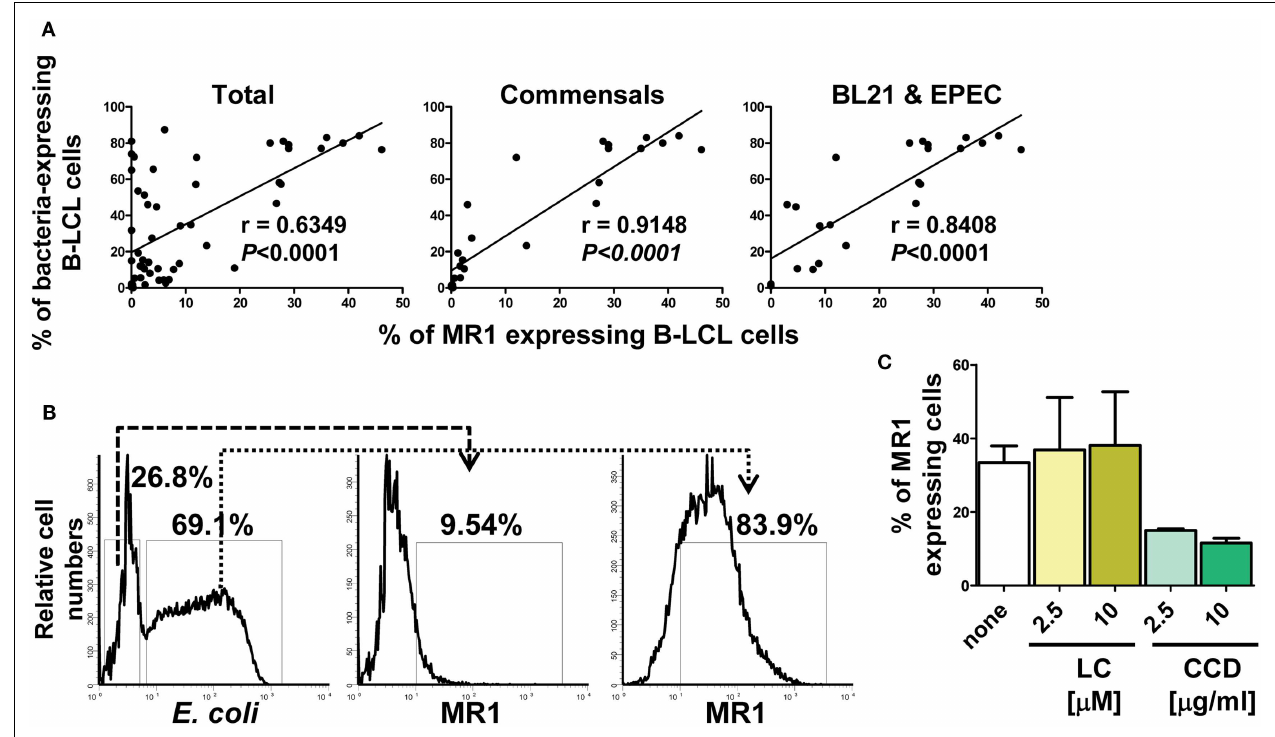
Correlation tests. (B) A representative flow cytometric experiment using polyclonal antibodies to E. coli antigens and to MR1. BL21-infected B-LCL were gated based on forward and side scatter (FS/SS) and then through a “dump” channel used to eliminate dead cells (ViViD + ). B-LCL were then gated as E. coli − and E. coli + respectively, and analyzed for their MR1 surface expression. (C) MR1 expression in the absence (none) or in the presence of inhibitors lactacystin (LC) and cytochalasin D (CCD) at different concentrations. B-LCLs were pretreated with LC and CCD for 2h before infection. Data are representative of five (A) and two (B,C)